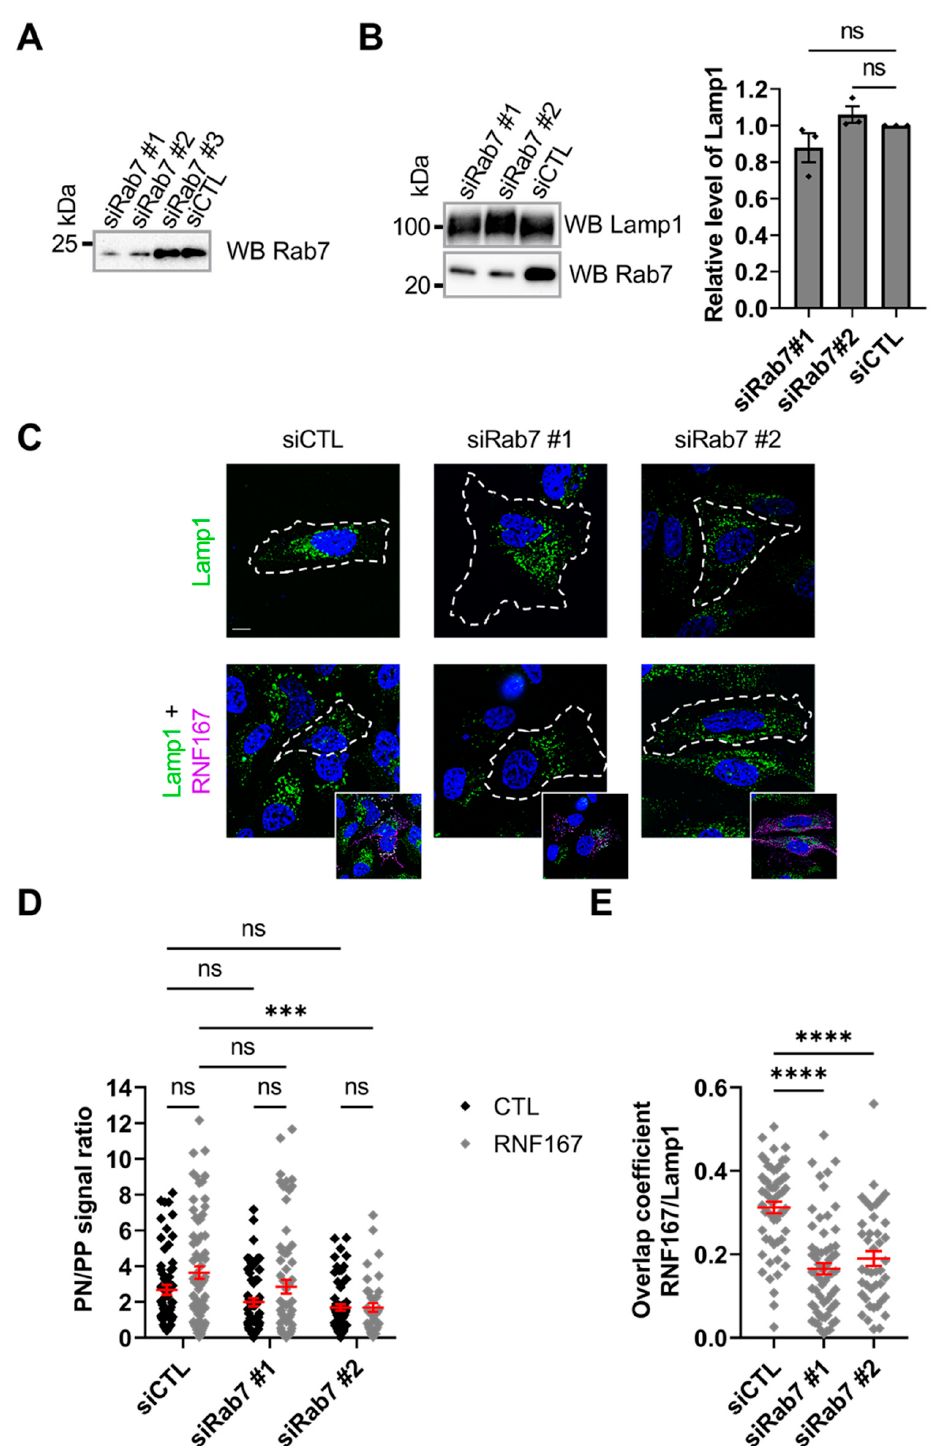
Figure 4. Rab7 is involved in lysosome positioning in cells . ( A ) Rab7 knockdown efficiency in HeLa cells transfected with DsiRab7s. Lysates were probed against endogenous Rab7 protein. siCTL = control DsiRNA. Blot is a representative result of three separate experiments. ( B ) Rab7 depletion does not alter endogenous Lamp1 protein abundance. DsiRab7-transfected HeLa cell lysates were probed for Lamp1 and Rab7 (left). Blots are representative results of three separate experiments. The stain-free signal (not shown) was used to normalize protein for quantitative analysis of Lamp1 abundance (right). siCTL = control DsiRNA. Non-parametric one-way ANOVA with Kruskal–Wal-